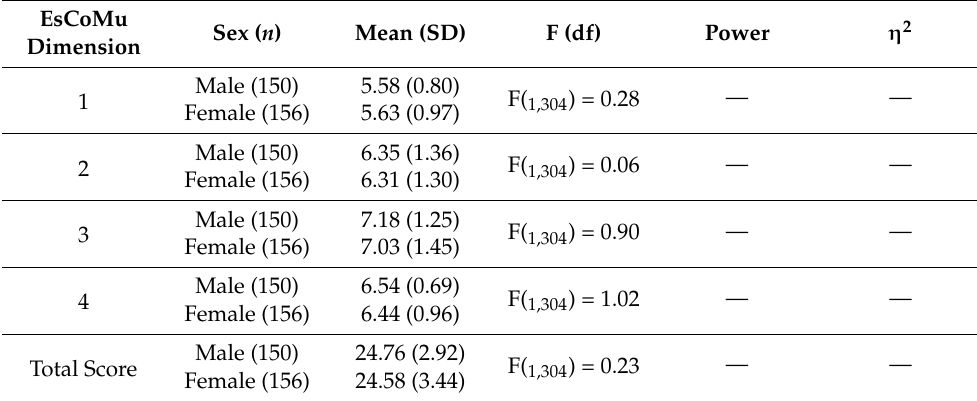
Table 7. MANOVA results for gender with EsCoMu dimensions and total